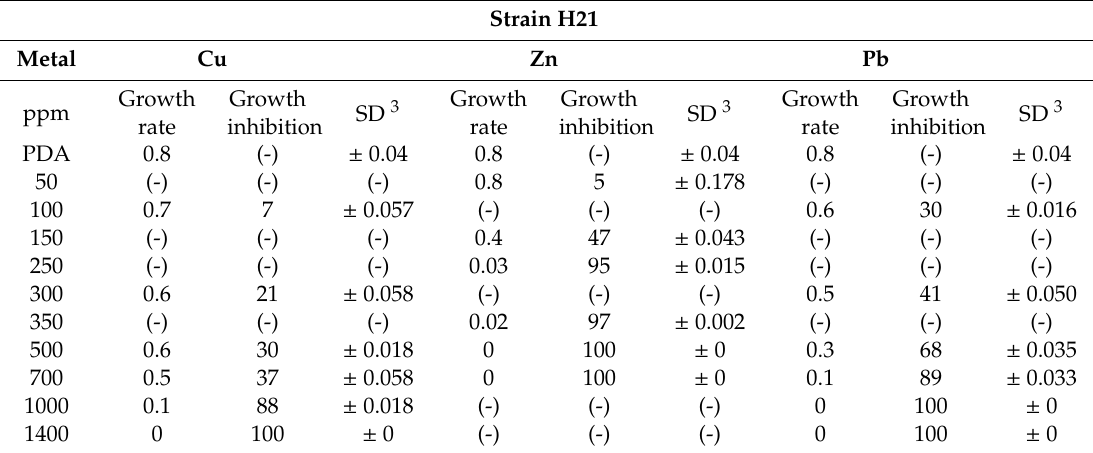
Table 2. Growth and percentage inhibition values for strain H21 in different metal concentrations.